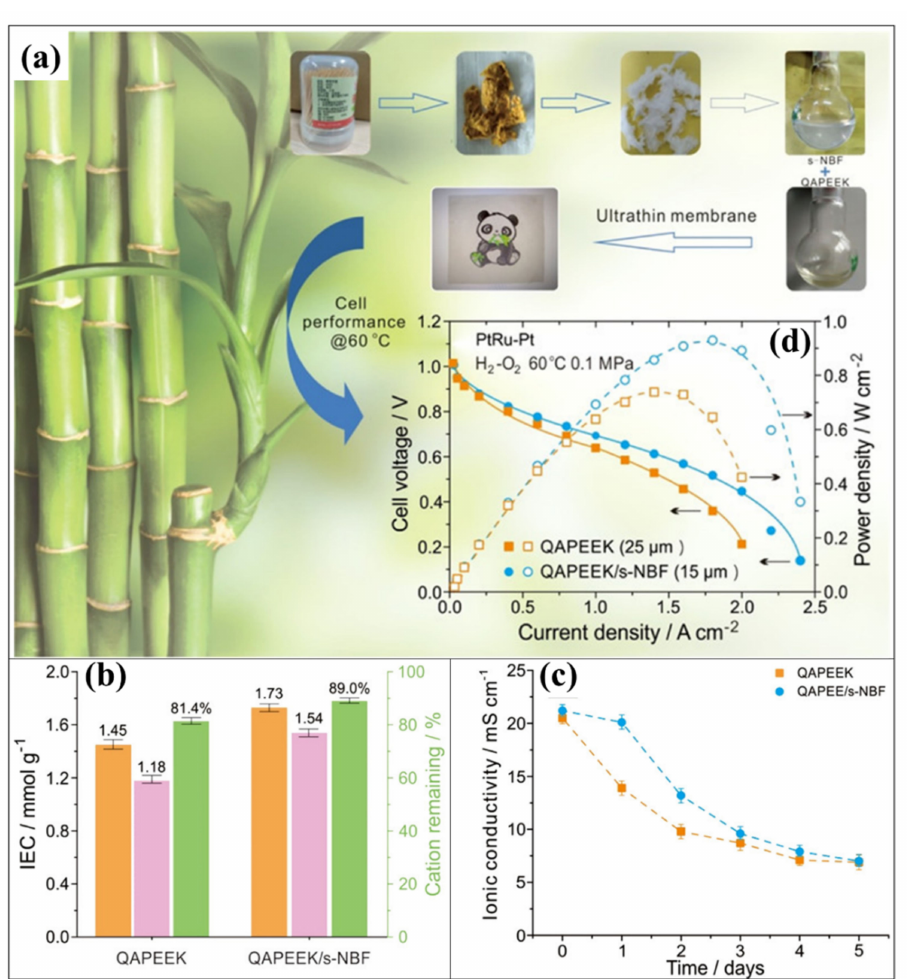
Figure 12. ( a ) Representation of cellulose fiber (CF) derived process from the bamboo and membrane developments QAPEEK membrane with sulfonated CF (SCF). ( b ) IEC, ( c ) IC, and ( d ) fuel cell performances of pure QAPEEK and QAPEEK − SCF membranes. Reprinted with permission from Ref. [177]. Copyright © 2018, American Chemical